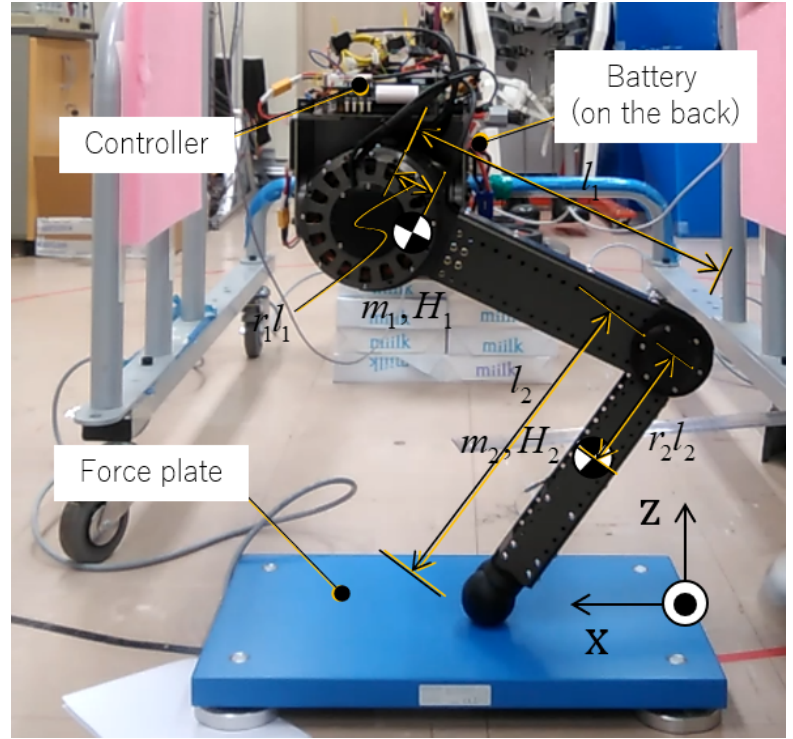
Figure 12. Experimental